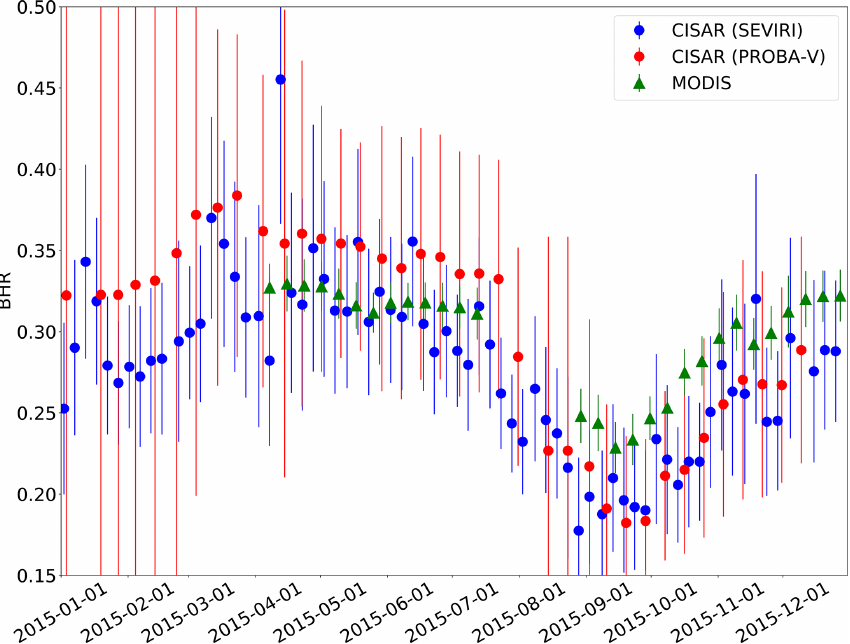
Figure 13. CISAR-retrieved BHR from SEVIRI (blue dots) and PROBA-V (red dots) and MODIS land product (green triangle) over Zinder Airport (Niger, Africa). The results are shown for each sensor’s band centred at 0.6µm for the year 2015. The vertical bars represent the retrieval uncertainty for SEVIRI and PROBA-V and standard deviation over the selected area for